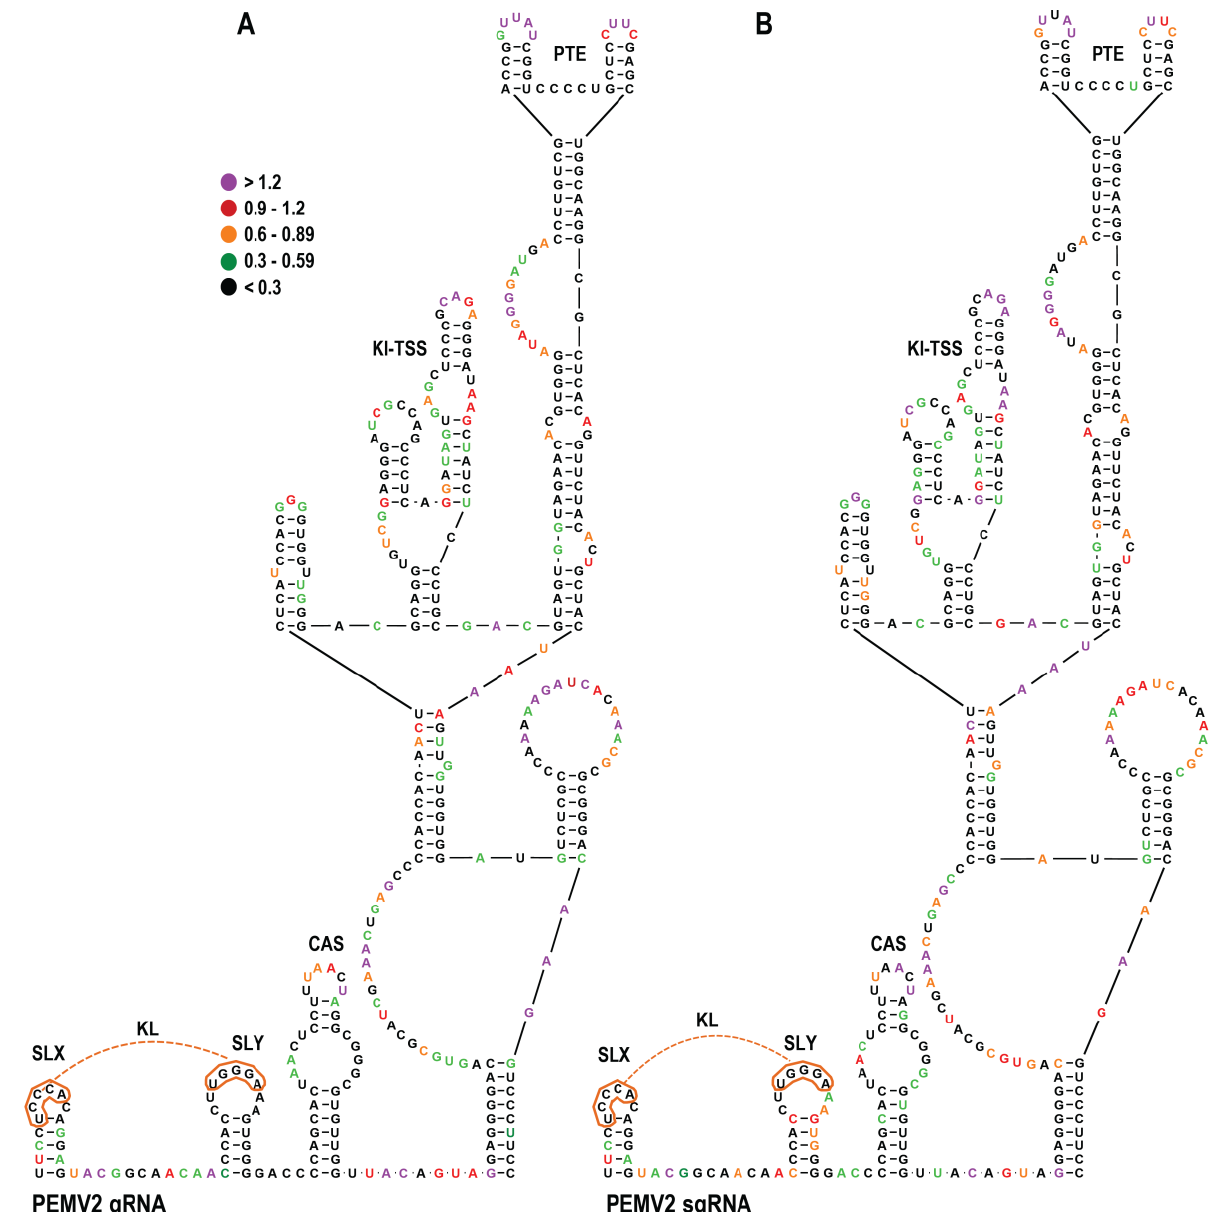
Figure 8. SHAPE probing of the CAS region in full-length PEMV2 gRNA and sgRNA. ( A ). SHAPE reactivity of gRNA residues. Individual residue “dots” are colored according to NMIA reactivity, from purple (most reactive) to black (least reactive). gRNA structures are labeled for clarity. ( B ). SHAPE reactivity of sgRNA residues .